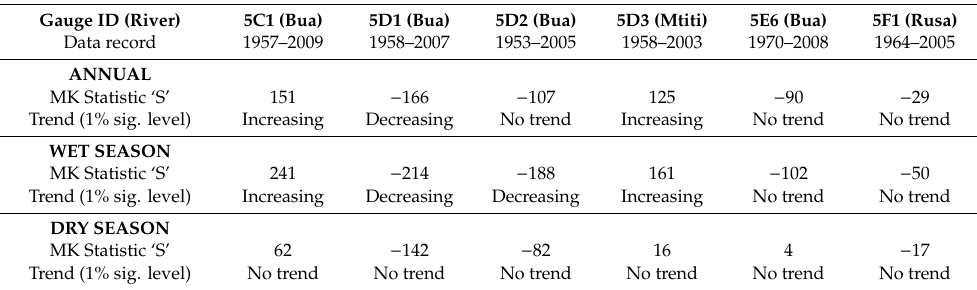
Table 5. Mann Kendall statistical results for BFI for gauges in WRA